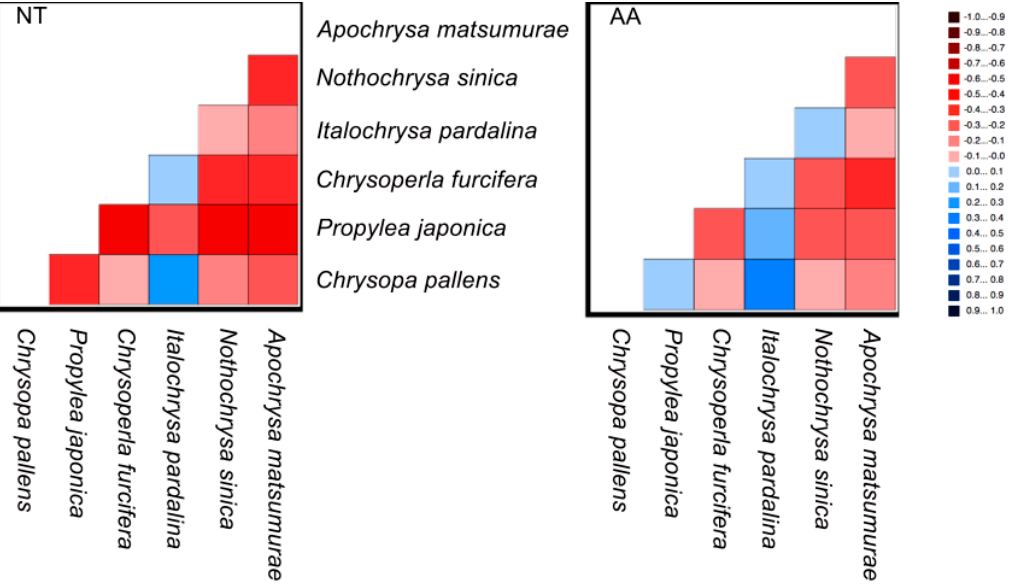
Figure 3. AliGROOVE analyses of nucleotide (NT) and amino acid (AA) sequences. The mean similarity score between the sequences is represented by a colored square, based on AliGROOVE scores from − 1, indicating a great difference in rates from the remainder of the dataset (i.e., heterogeneity (red), to +1, indicating rates matching those from all the other comparisons (blue).